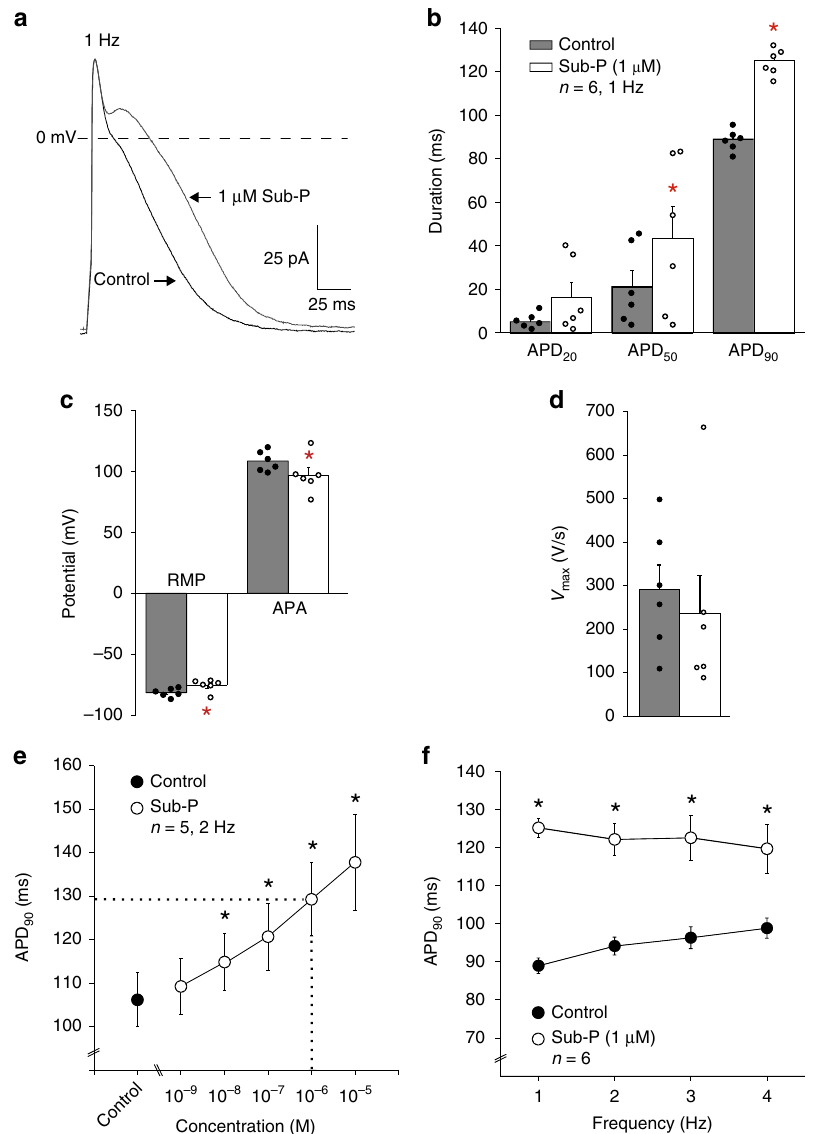
Fig. 1 Effect of substance-P on action potential parameters of rabbit atrial cardiomyocytes. a APs elicited at 1 Hz from an atrial cardiomyocyte under control conditions and in the presence of 1 µ M Sub-P. b – d Bar graph showing average values for AP duration at 20, 50 and 90% of repolarization (APD 20 , APD 50 and APD 90 ) b , resting membrane potential (RMP) and action potential amplitude (APA) c , and maximal upstroke velocity ( V max ) d before (Control) and after application of 1 µ M Sub-P. ( N = 4, n = 6, paired t -test.) e Concentration-dependence of APD 90 before (Control) and after application of increasing concentrations of Sub-P. Dotted lines: concentration of Sub-P at which the increase of APD 90 exceeded 20%. ( N = 4, n = 5, one-way RM ANOVA.) f Frequency-dependence of APD 90 before (Control) and after application of 1 µ M Sub-P ( N = 4, n = 6, two-way RM ANOVA). All values shown are mean ± SEM. * P <